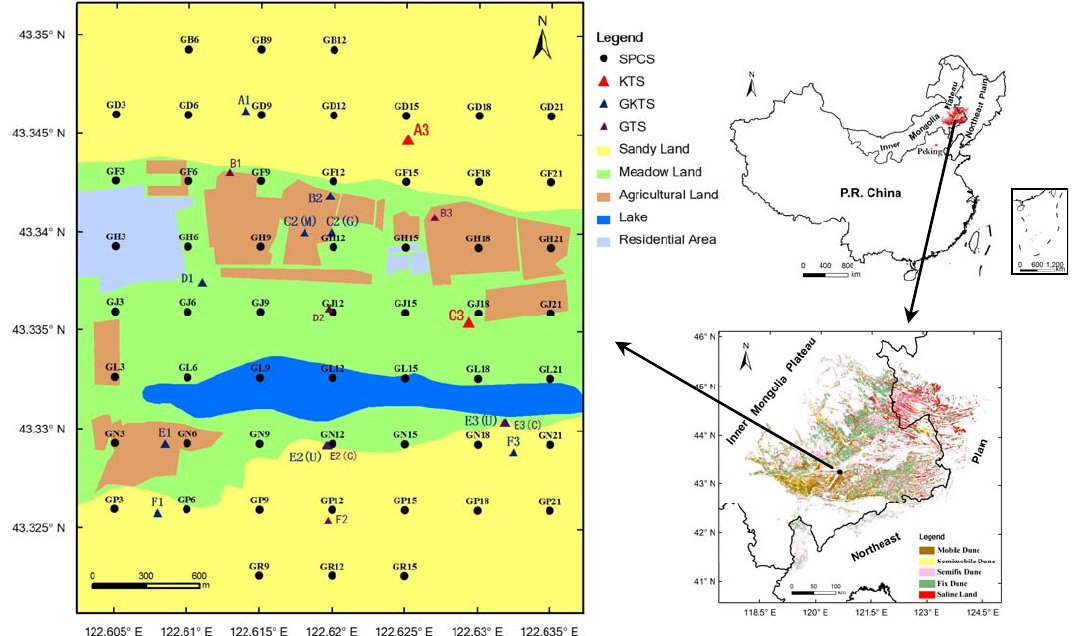
Fig. 1. The location and landscape features of the study area, soil physicochemical sites (SPCS) and hydrologic and meteorological stations (KTS, GKTS, and GTS). 4